Question: How would you classify this visualization?
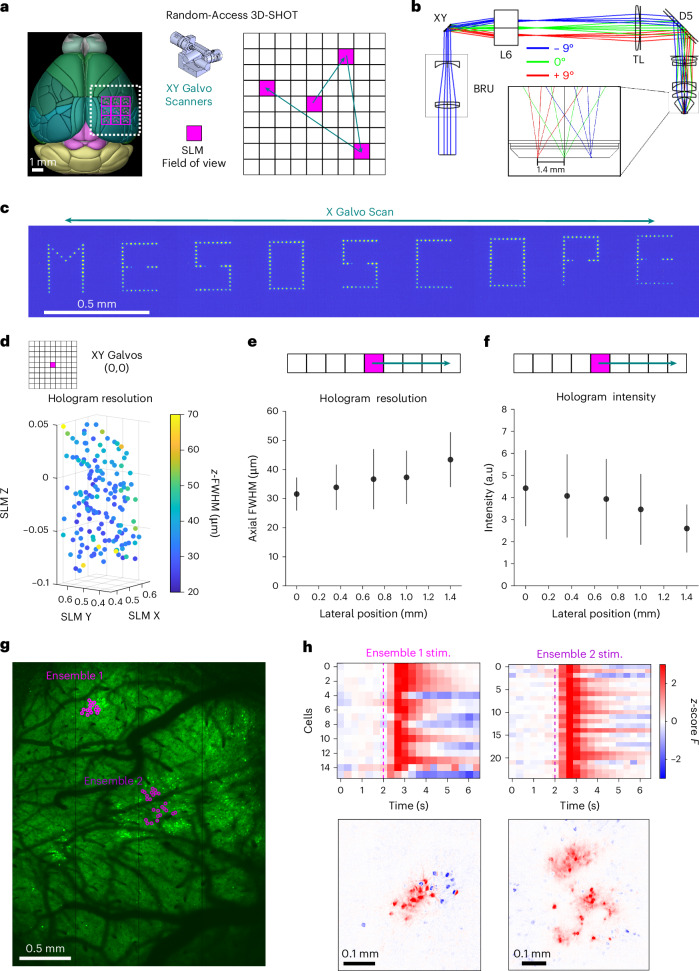
Answer: histogram